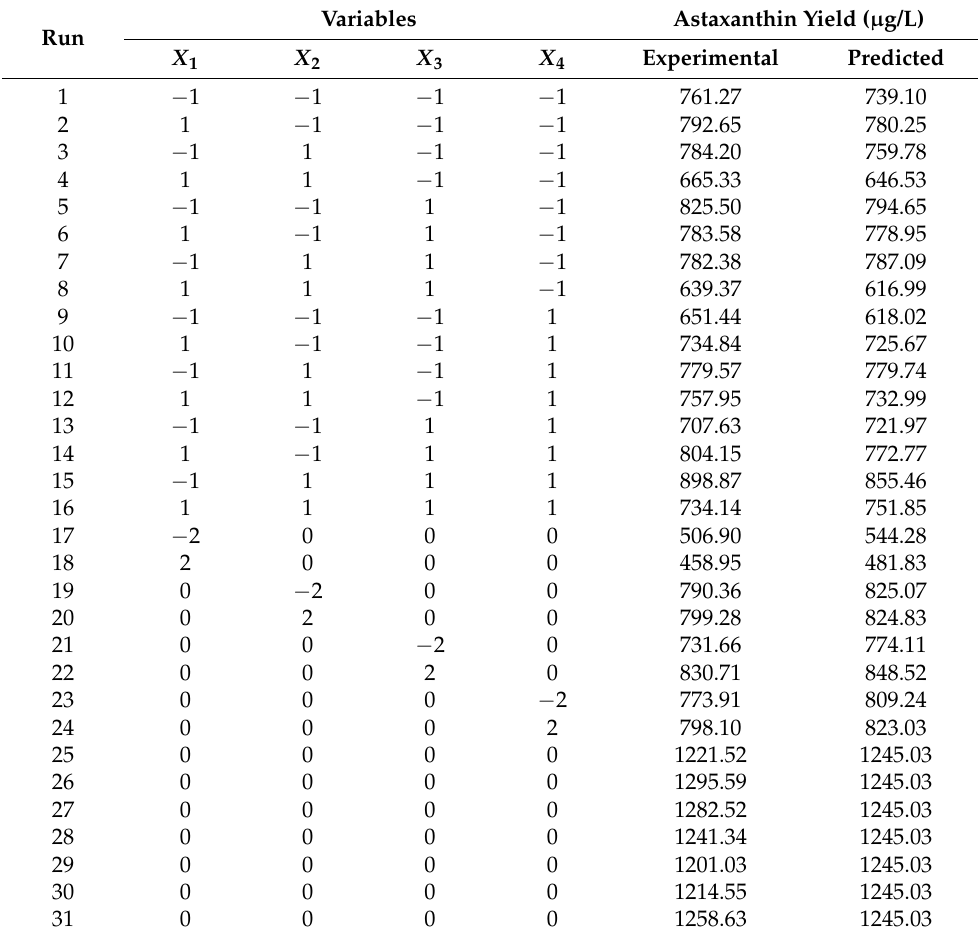
Table 2. Experimental design of the RSM-CCD model and experimental results. Run